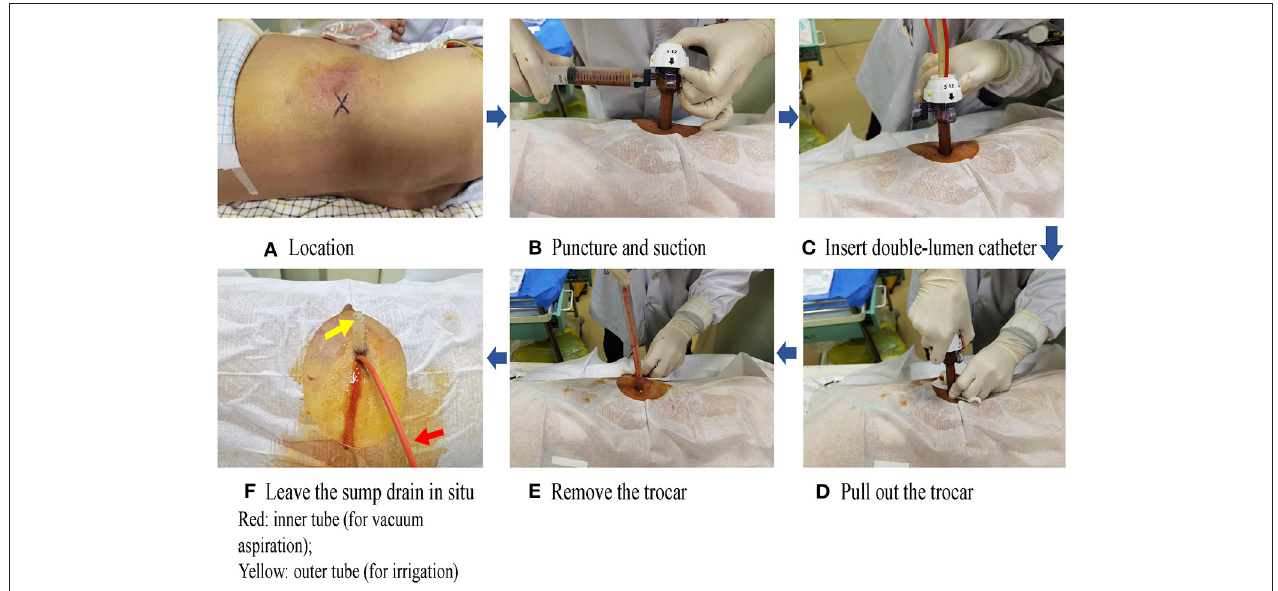
FIGURE 1 | Procedure of trocar puncture with a sump drain. The actual figures and all tables have been uploaded as separate items. (A) Location, (B) Puncture and suction, (C) Insert double-lumen catheter, (D) Pull out the trocer, (E) Remove the trocer, (F) Leave the sump drain in-situ Red: Inner tube (for vaccum aspiration); Yellow: outer tube (for